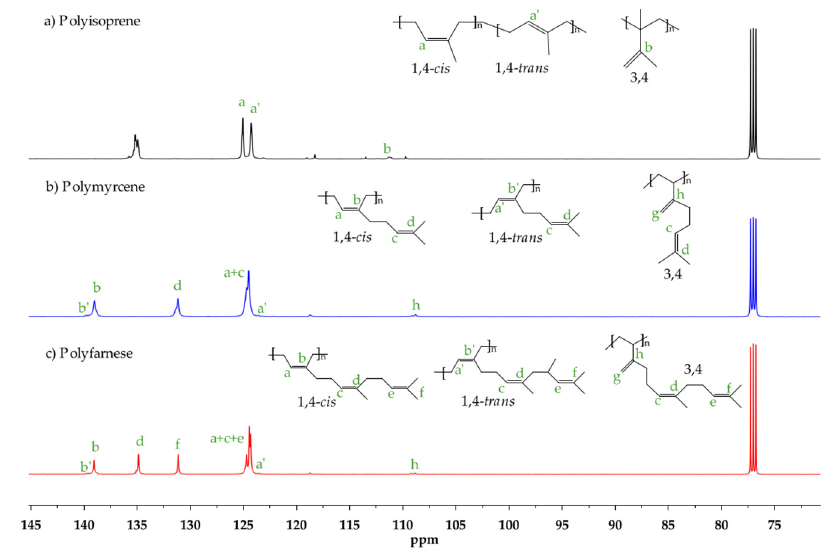
Figure 4. 13 C NMR spectra using CDCl 3 as a solvent on ( a ) Ip: entry Ip-11, ( b ) My: entry My-11, and ( c ) Fa: entry Fa-15.